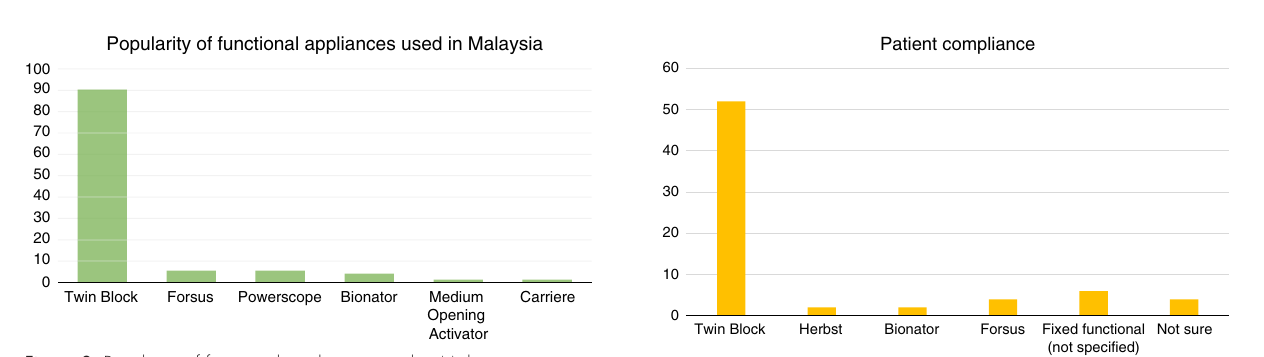
Figure 5. Functional appliance with the best patient